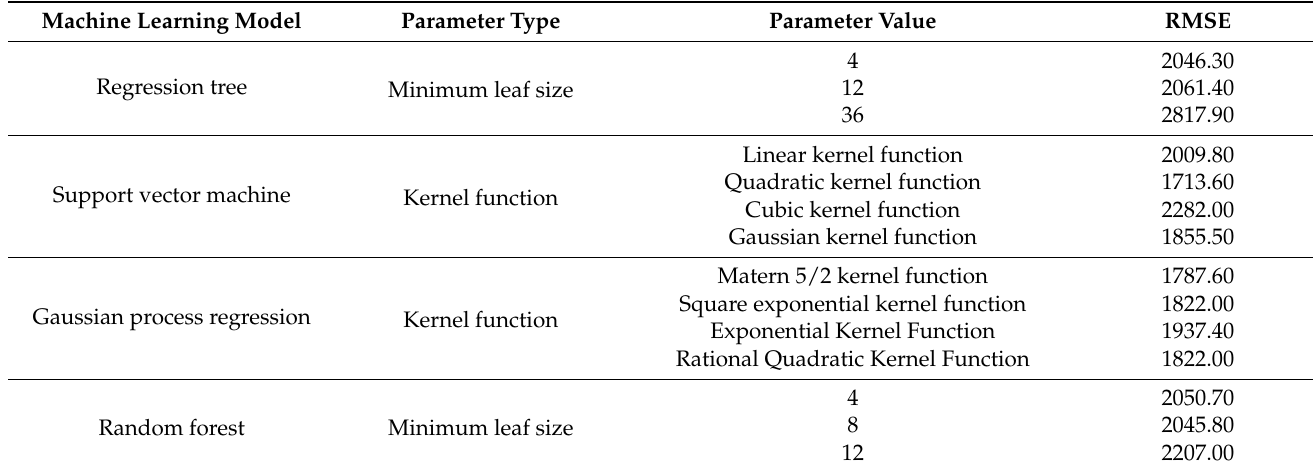
Table 2. RMSE of different parameters of machine learning regression model of secondary industry